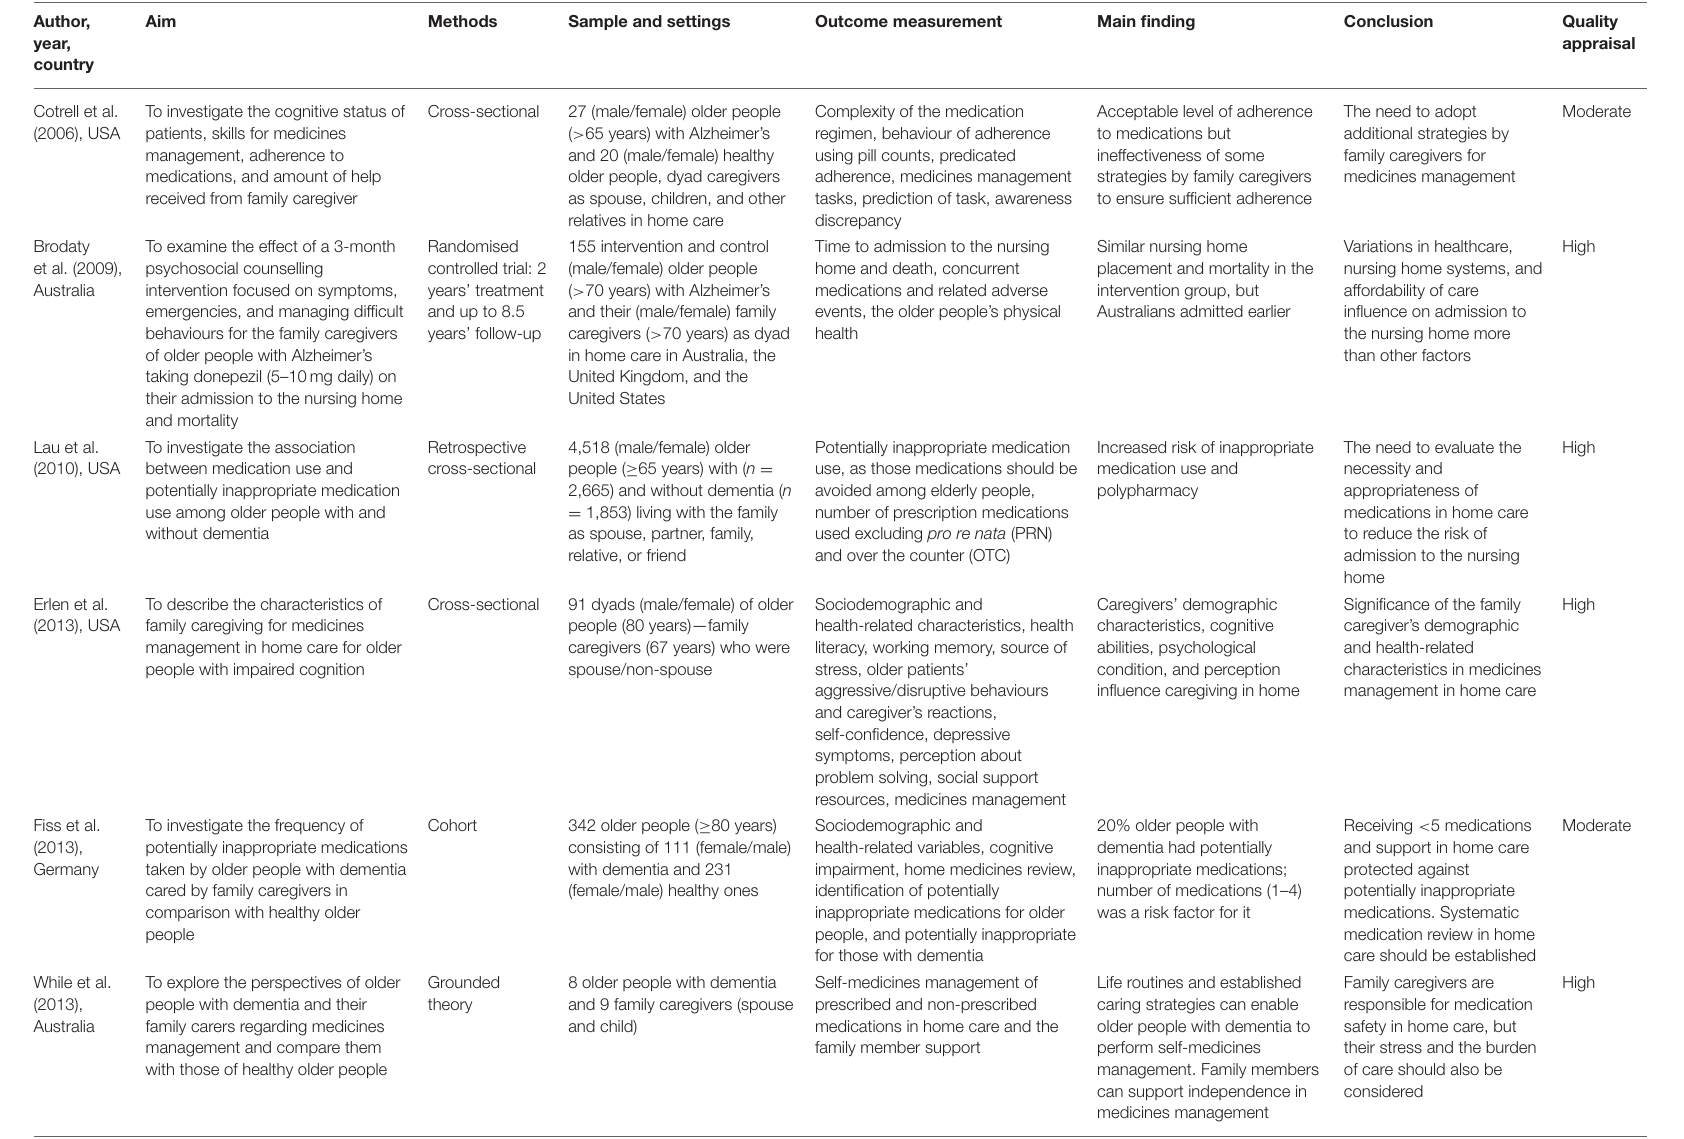
TABLE 2 | General characteristics of selected studies included to data analysis and knowledge